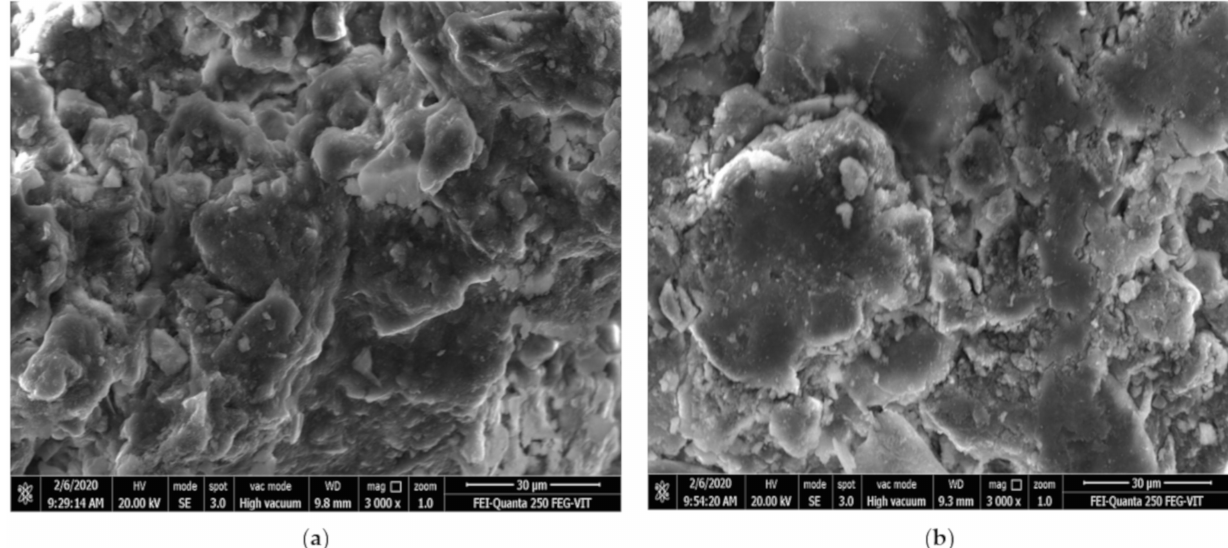
Figure 9. Field emission scanning electron microscopy (FE-SEM) images of ( a ) topsoil, ( b ) second layer soil.